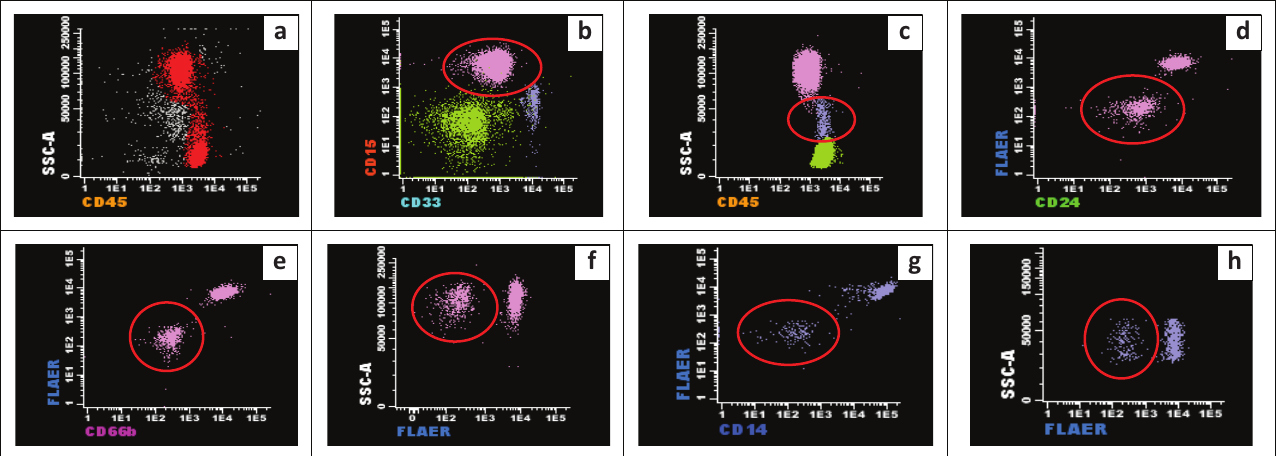
FIGURE 1: Gating strategy for paroxysmal nocturnal haemoglobinuria clones, South Africa, September 2013 – January 2018. (a) All white blood cells gated using CD45; (b) gated neutrophils; (c) gated monocytes; (d, e, f) the dual-negative granulocytes; (g, h) dual-negative monocytes.